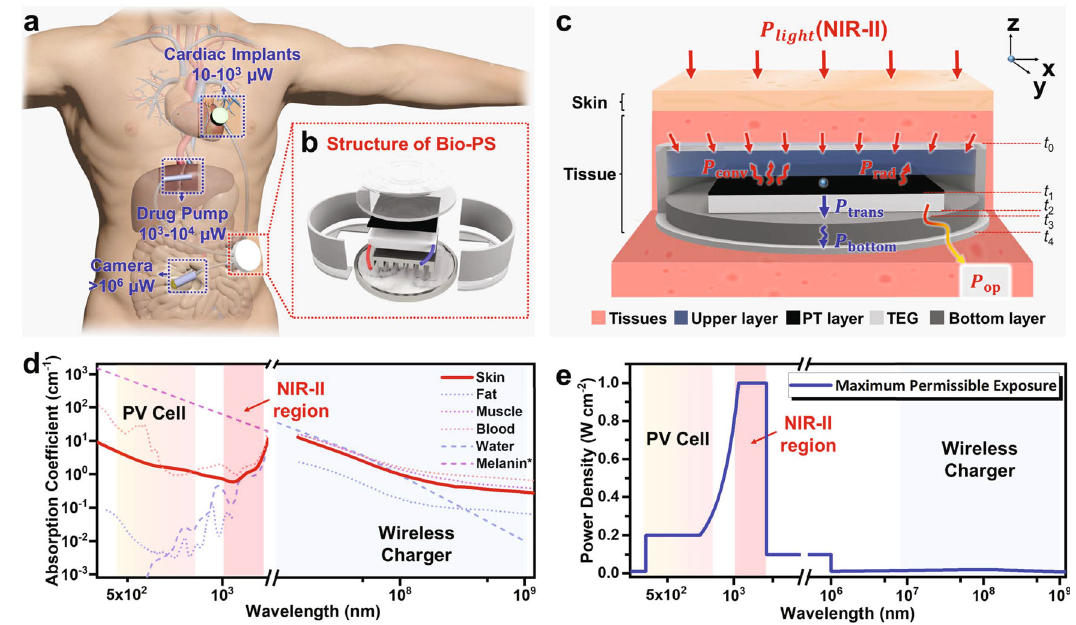
Fig. 1 | The subcutaneous power supply by NIR-II light. a The power consump- tionofclinicallyusedIMDsandtheimaginationofrechargingthosebatteriesinthe IMDs by a CPT device. b The disassembled structure of a subcutaneous power supply device made of a tandem combination of the photothermal converter and thermoelectric converter. c The heat transfer model of PTE converter under NIR-II light irradiation. d The absorption coef fi cient of light with different wavelengths